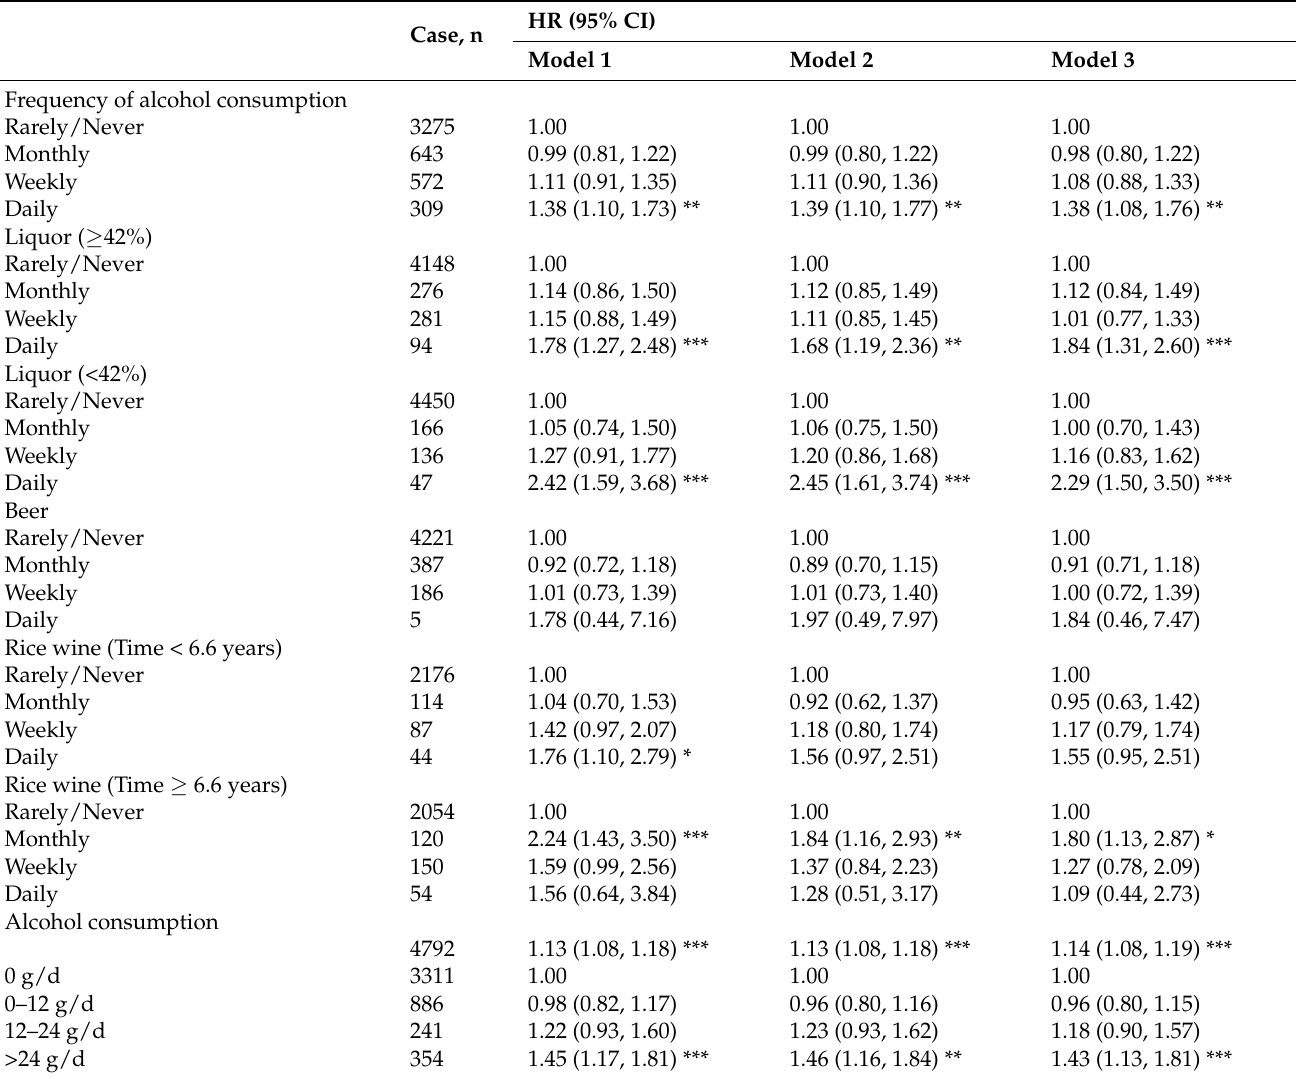
Table 3. Hazard ratios (95% confidence intervals) of hypertension associated with frequency of alcohol consumption among the employed. Case,